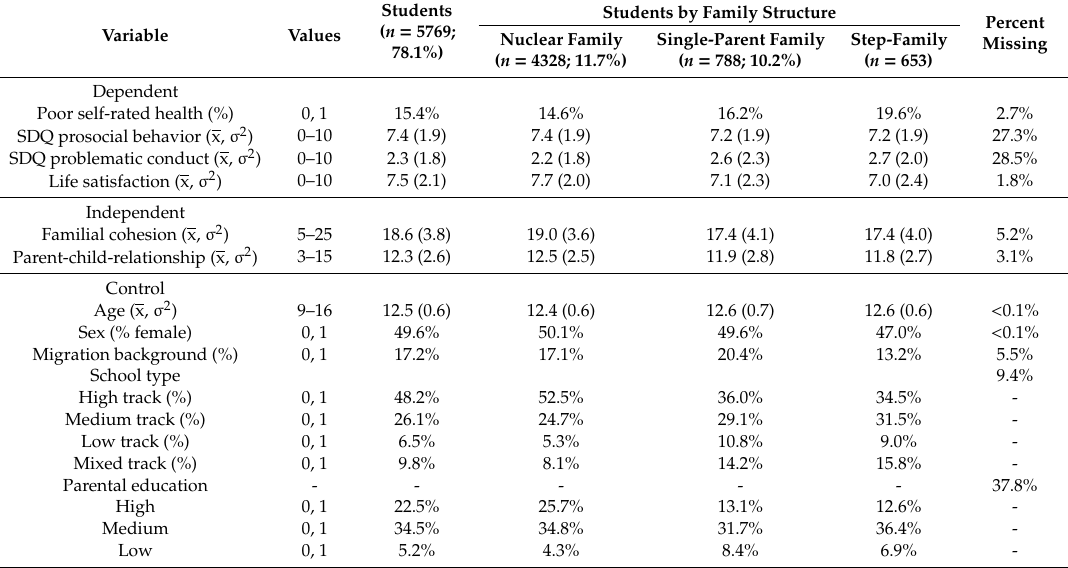
Notes: x = mean; σ 2 = standard